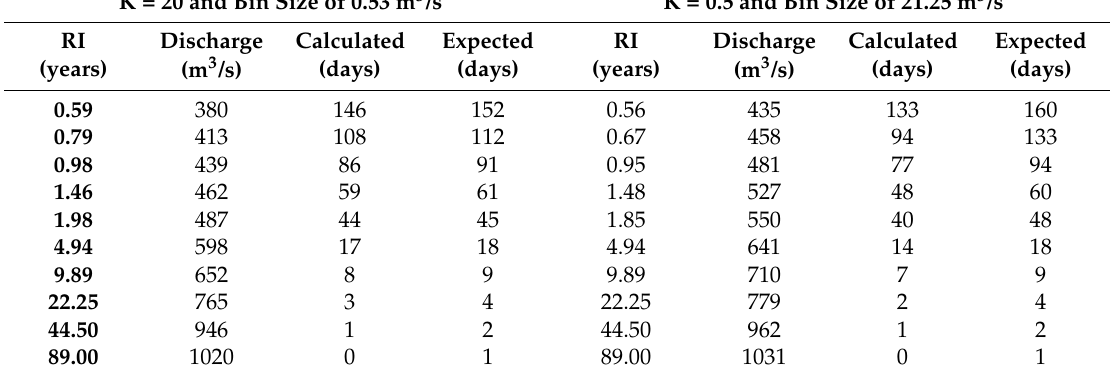
Table 7. Comparison of FDD method calculated exceedance and expected occurrences (reported as days) for different recurrence intervals. The difference between the calculated exceedances and expected occurrences were the number of discharge values in the bin with the maximum discharge shown. Reported results are for the Sandusky River, near Fremont Ohio, by using K values of 0.5 and 20 in Equation